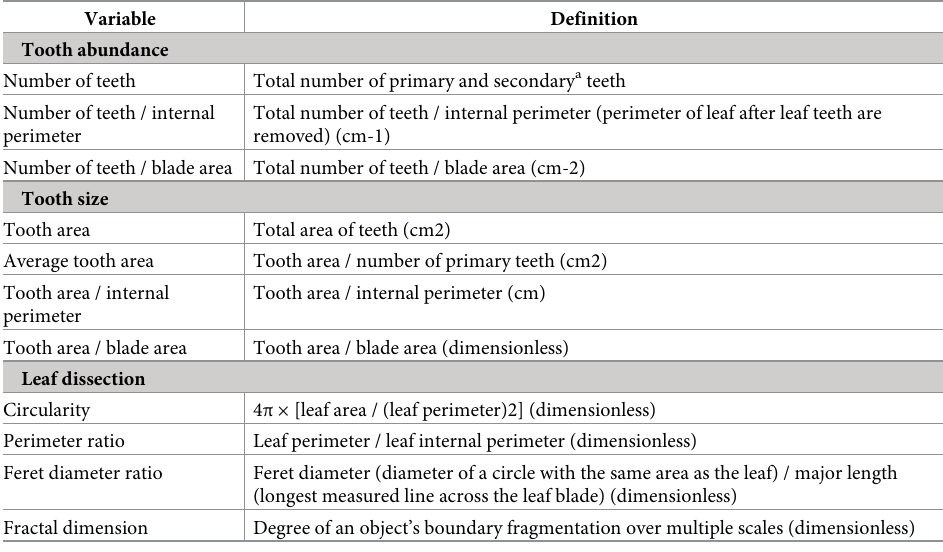
Table 1. Physiognomic variables and definitions.